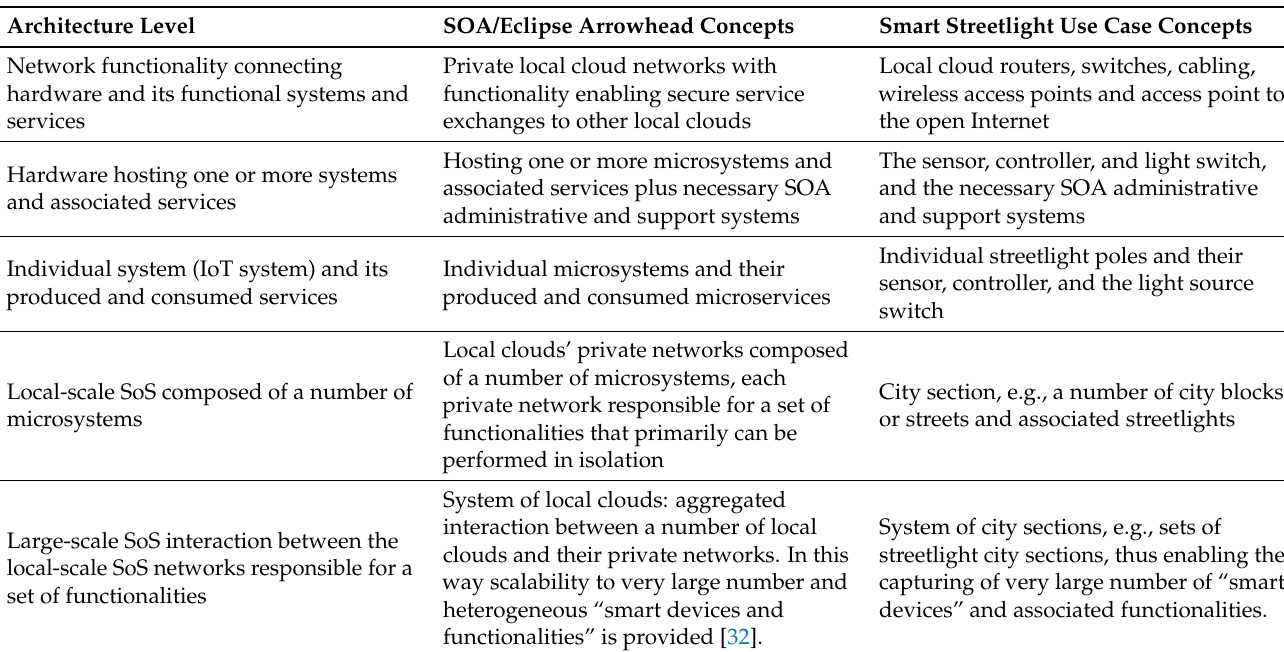
Table 1. The architectural view of the engineering approach. Here, the use case level and scale are indicated in green boxes with the corresponding architectural level from the Eclipse Arrowhead as stereotyped in SysML in yellow